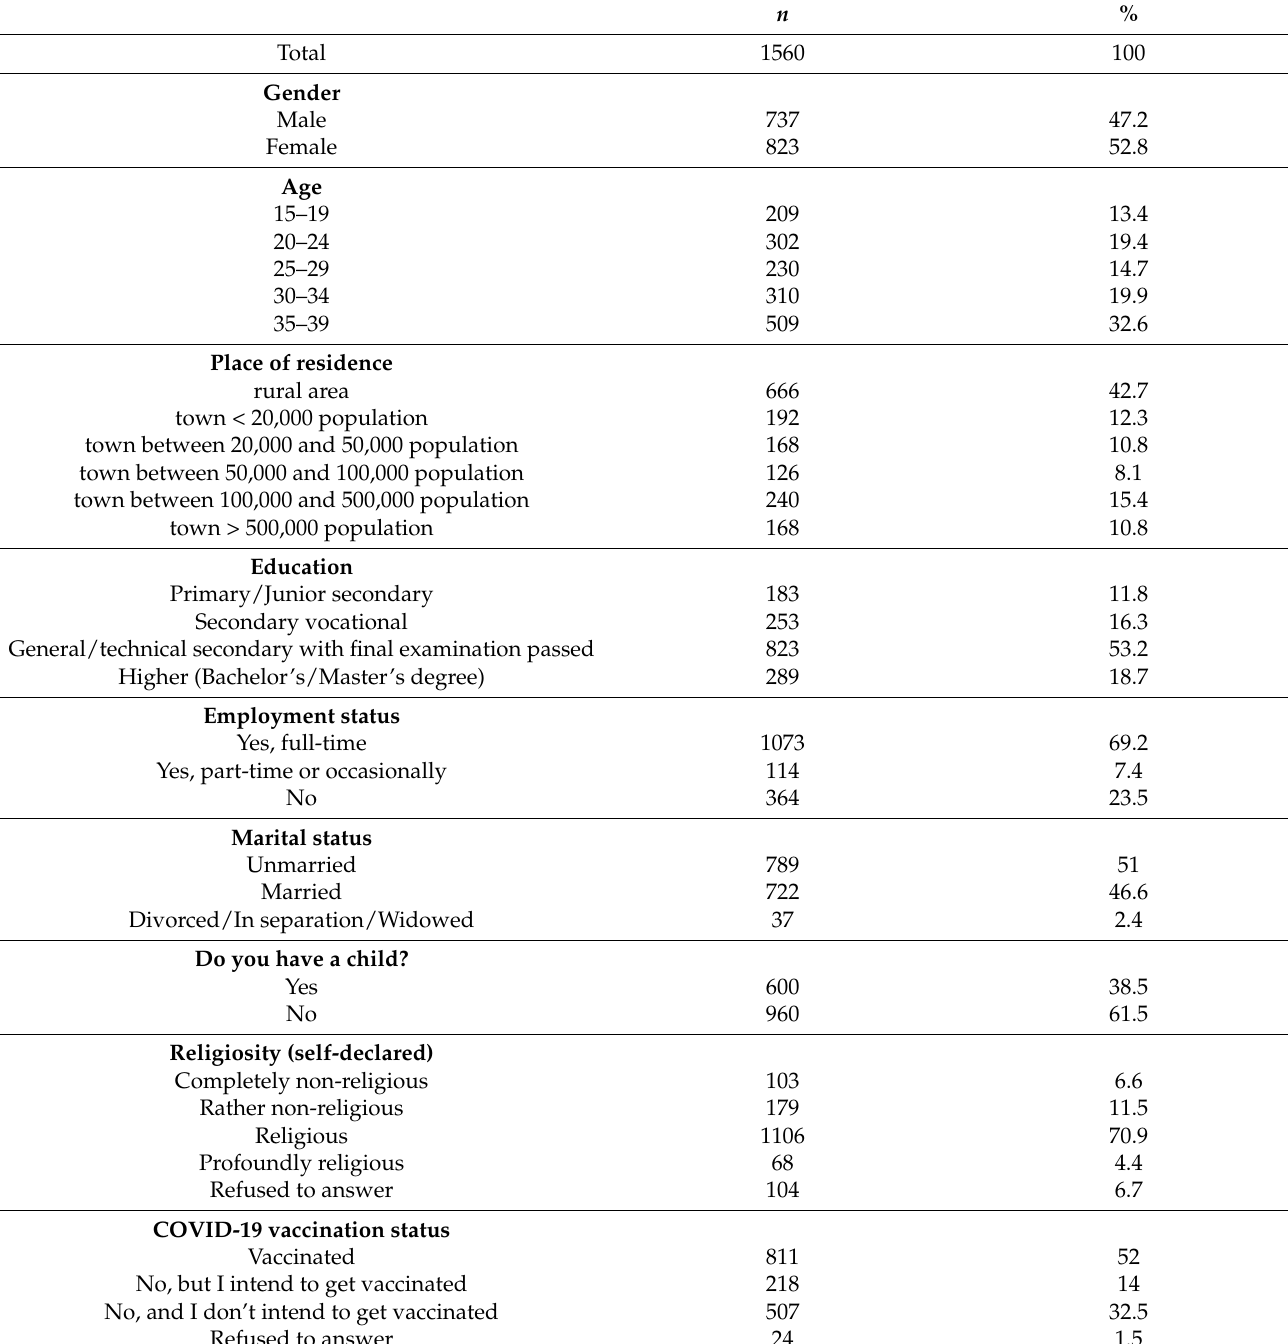
Table 1. Characteristics of the study